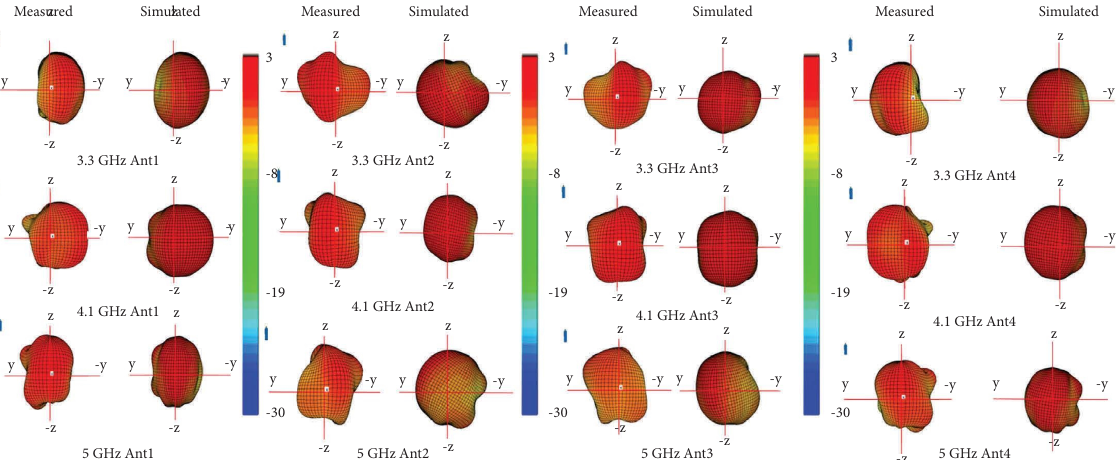
Figure 12: 3D radiation pattern of ANT1–ANT4.